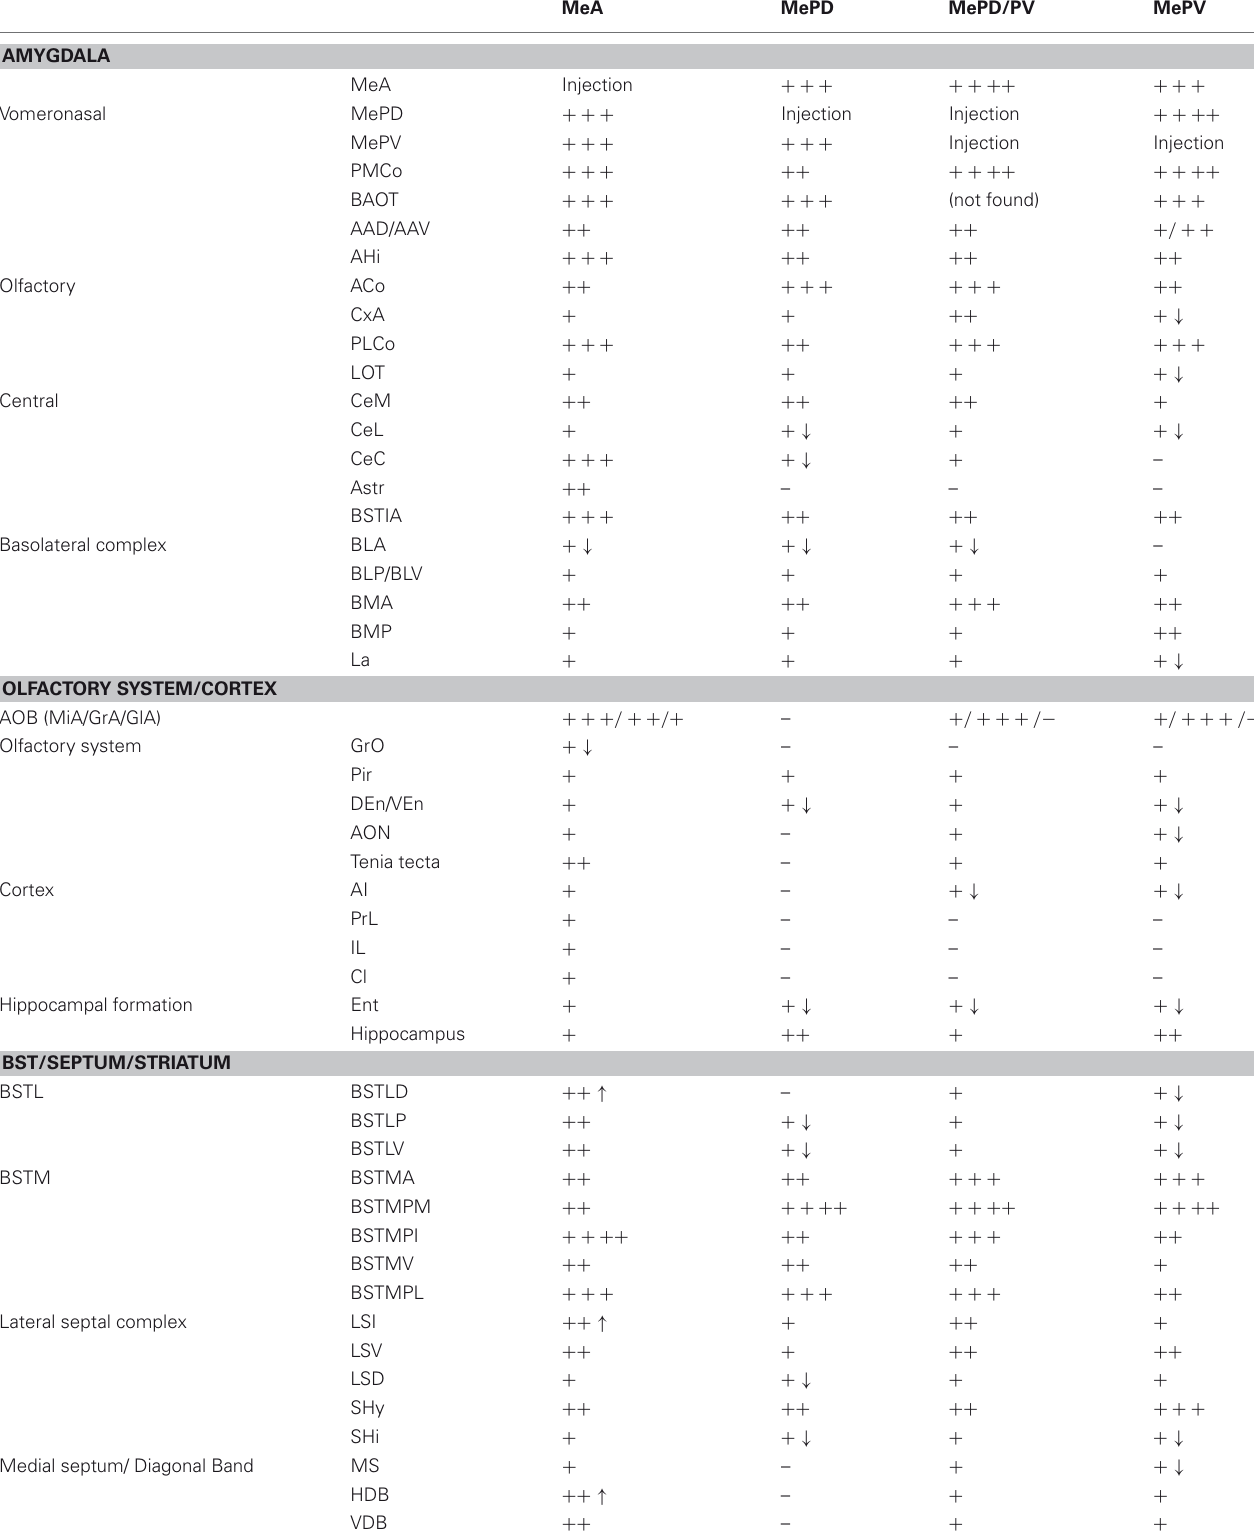
Table 1 | Semiquantitative rating of the density of the anterograde labeling resulting after tracer injections in three subnuclei of the medial amygdaloid